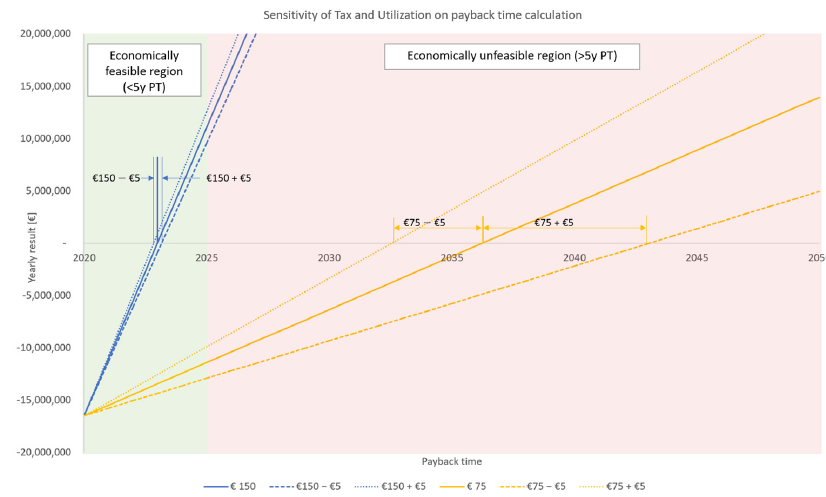
Figure 7. Payback period scenarios.5 year payback time as feasibility criterion.